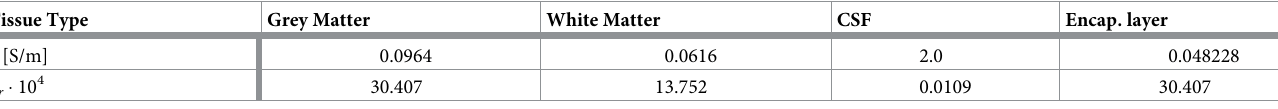
Table 1. Dielectric properties of brain tissue at 520 Hz [17]. Tissue